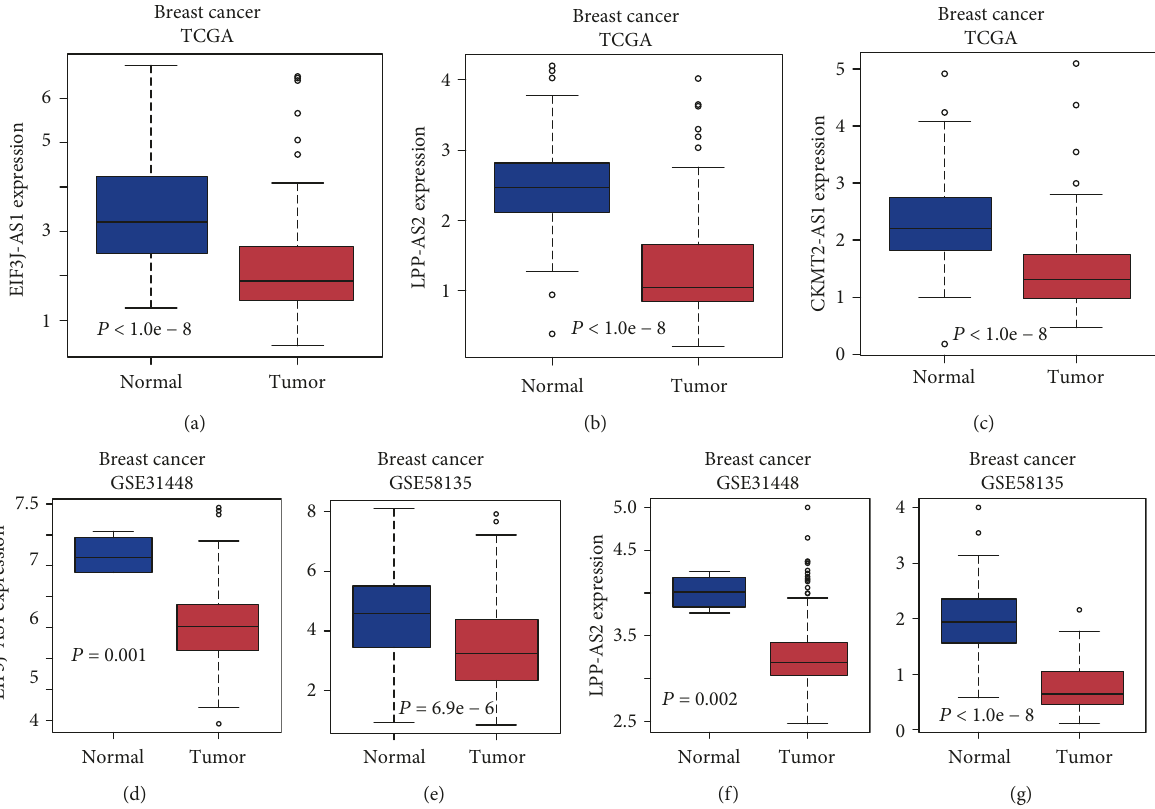
Figure 4: Cross-dataset expression of cell cycle-related lncRNAs. (a) EIF3J-AS1, (b) LPP-AS2, and (c) CKMT2-AS1 are downregulated in tumors versus normal tissues in the TCGA breast cancer dataset. (d) EIF3J-AS1 is downregulated in tumor versus normal tissues in the GSE31448 and (e) GSE58135 datasets. (f) LPP-AS2 is downregulated in tumor versus normal tissues in the GSE31448 and (g) GSE58135